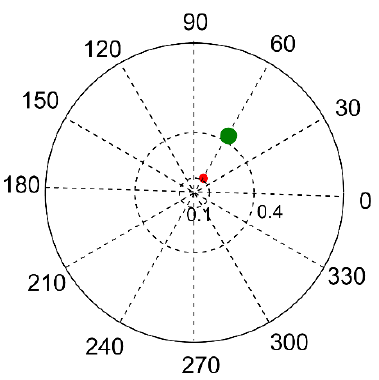
ω ω Figure 8. ~ e evolution over 25 T , red points correspond to Figure 8. ~ e evolution over 25 T , red points correspond